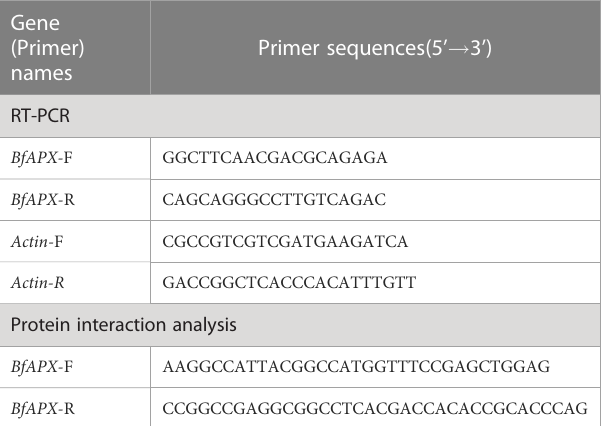
TABLE 2 Primer sequences for molecular